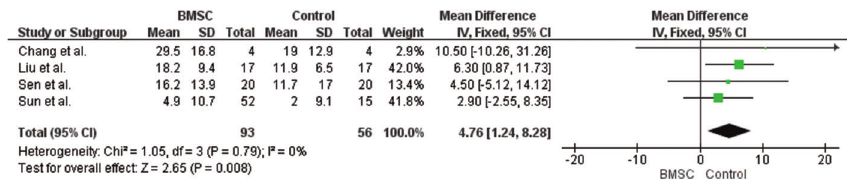
Figure 4 - Forest plot for the HHS improvement after bone marrow stem cell